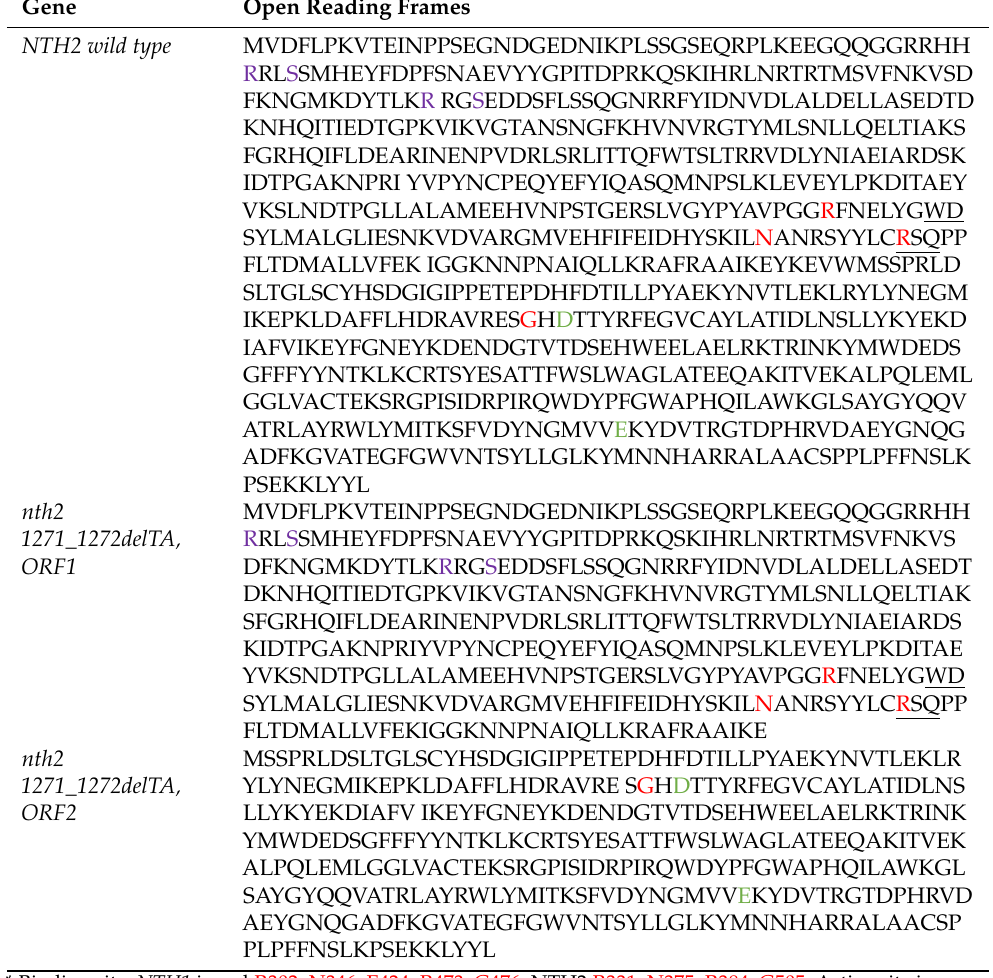
Table 1. Cont. Gene Open Reading